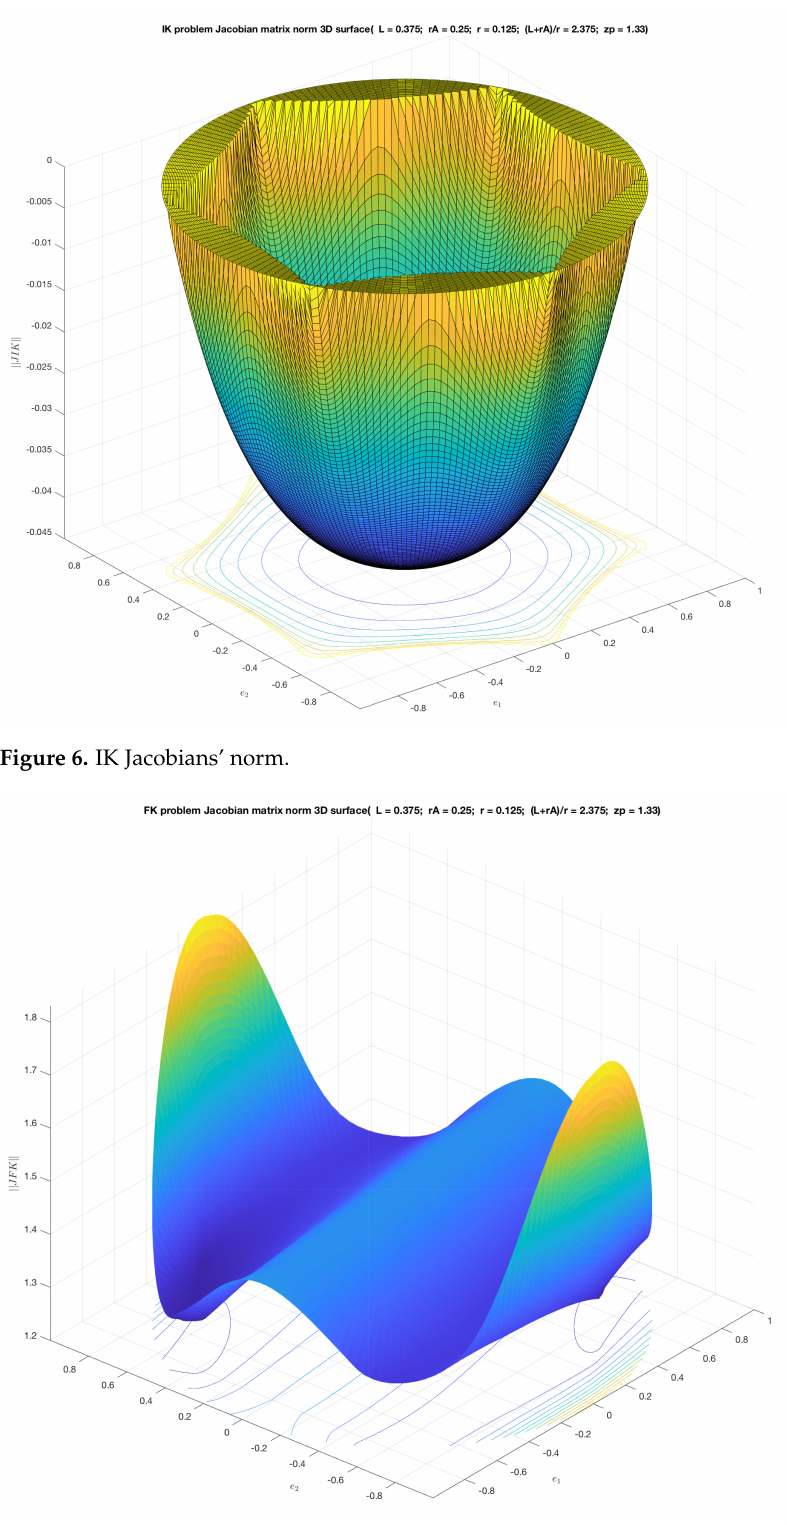
Figure 7. FK Jacobians’